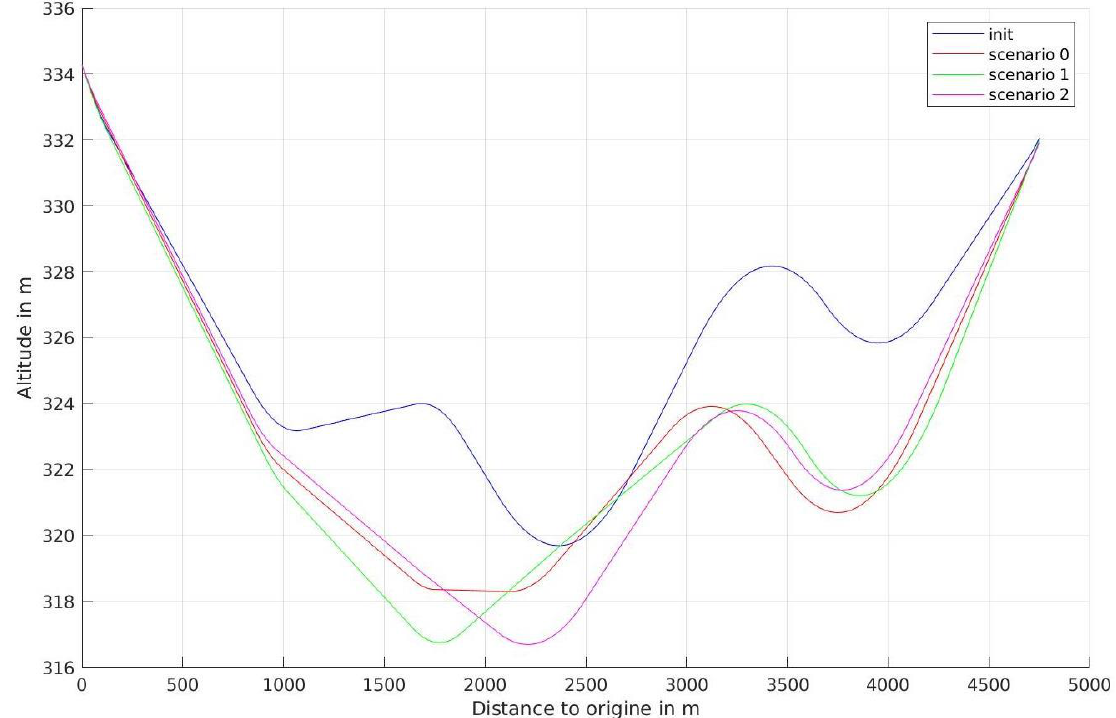
Figure 6. Optimized profiles for different